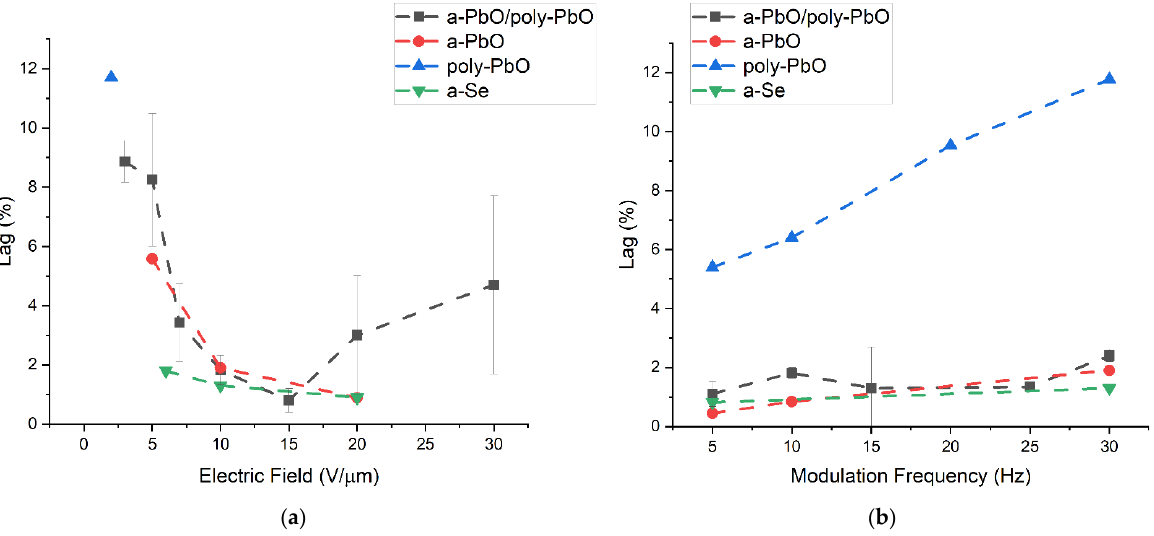
Figure 7. Signal lag as a function of ( a ) electric field for 30 Hz modulation frequency and ( b ) varying frequency for an applied electric field of 10 V/µm in a-PbO, bilayer PbO and a-Se, and 2 V/µm for poly-PbO [18,22,34,40]. Error bars have been added for the a-PbO/poly-PbO sample that was evaluated for this work. Data points are connected with dashed lines as a guide for the eye.